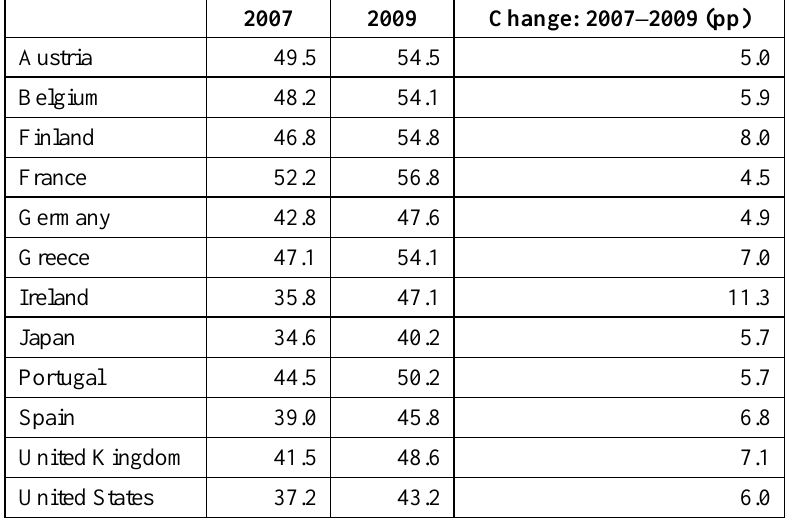
Table 2. Public expenditure (% of GDP) in twelve OECD member countries, 2007 and 2009 (OECD,